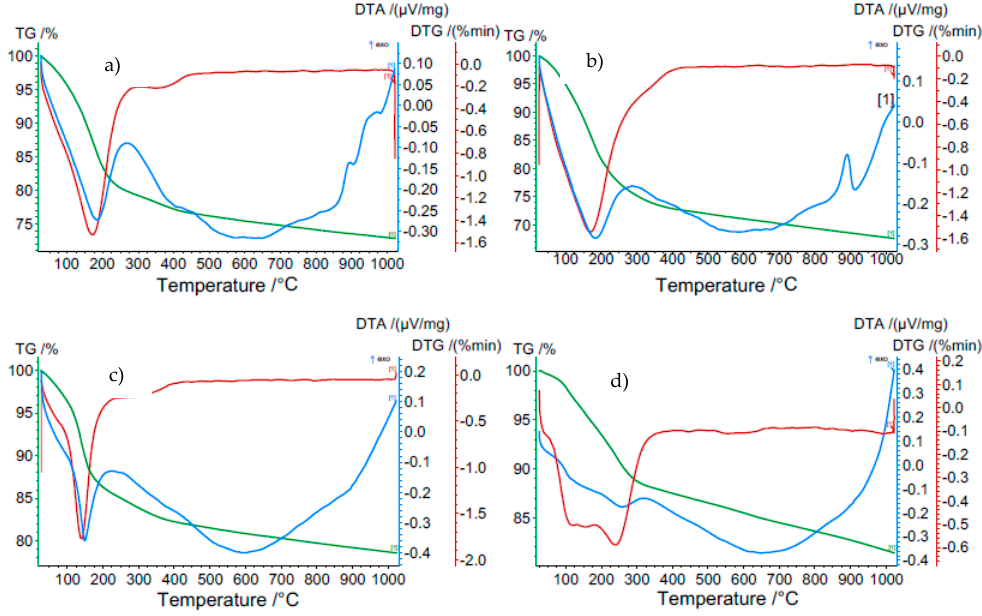
Figure 2. The thermogravimetric analysis (TG) and differential thermal analysis (DTA) graphs zeolite materials used in research: ( a ) NaA; ( b ) NaX; ( c ) NaP1; ( d ) sodalite.